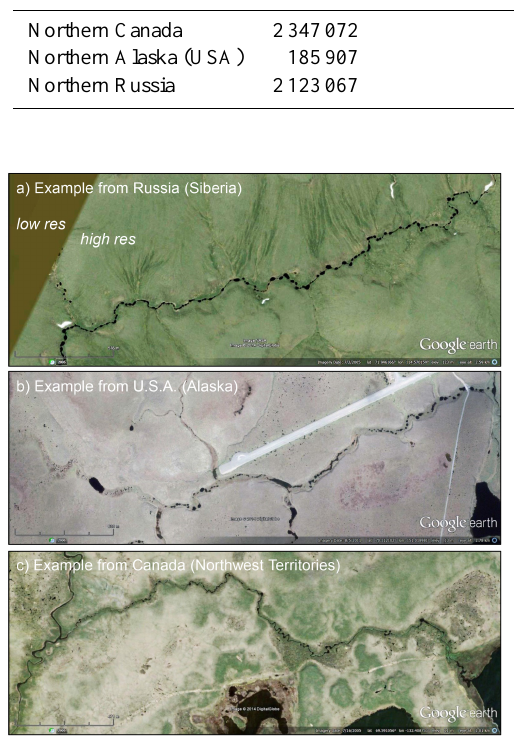
Figure 1. Examples of beaded stream networks located by scan- ning high-resolution (<5m) imagery available in Google Earth in (a) Russia (Anabar River watershed), (b) USA (near Nuiqsut, Alaska), and (c) Canada (Tuktoyaktuk